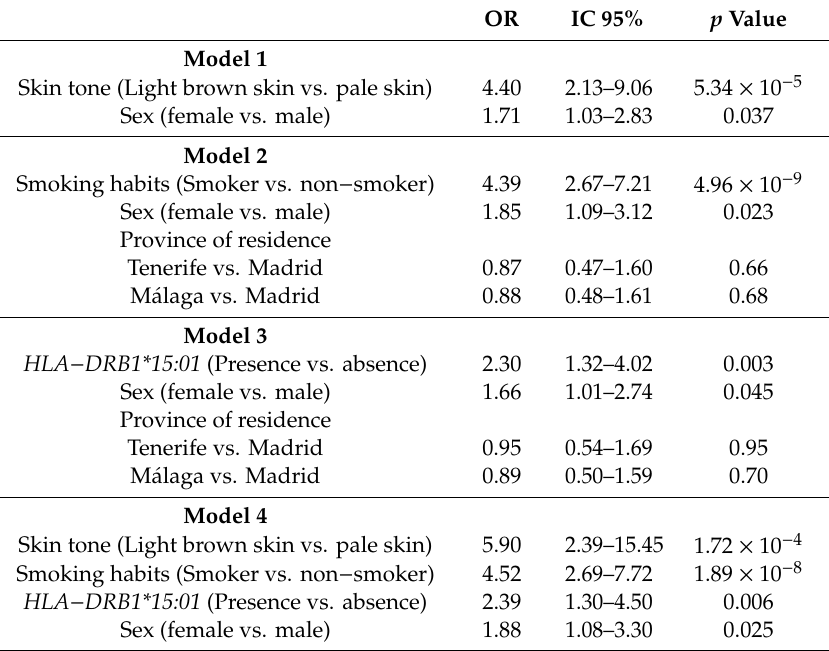
Table 2. Association of di ff erent variables with multiple sclerosis (MS) risk. OR IC 95% p